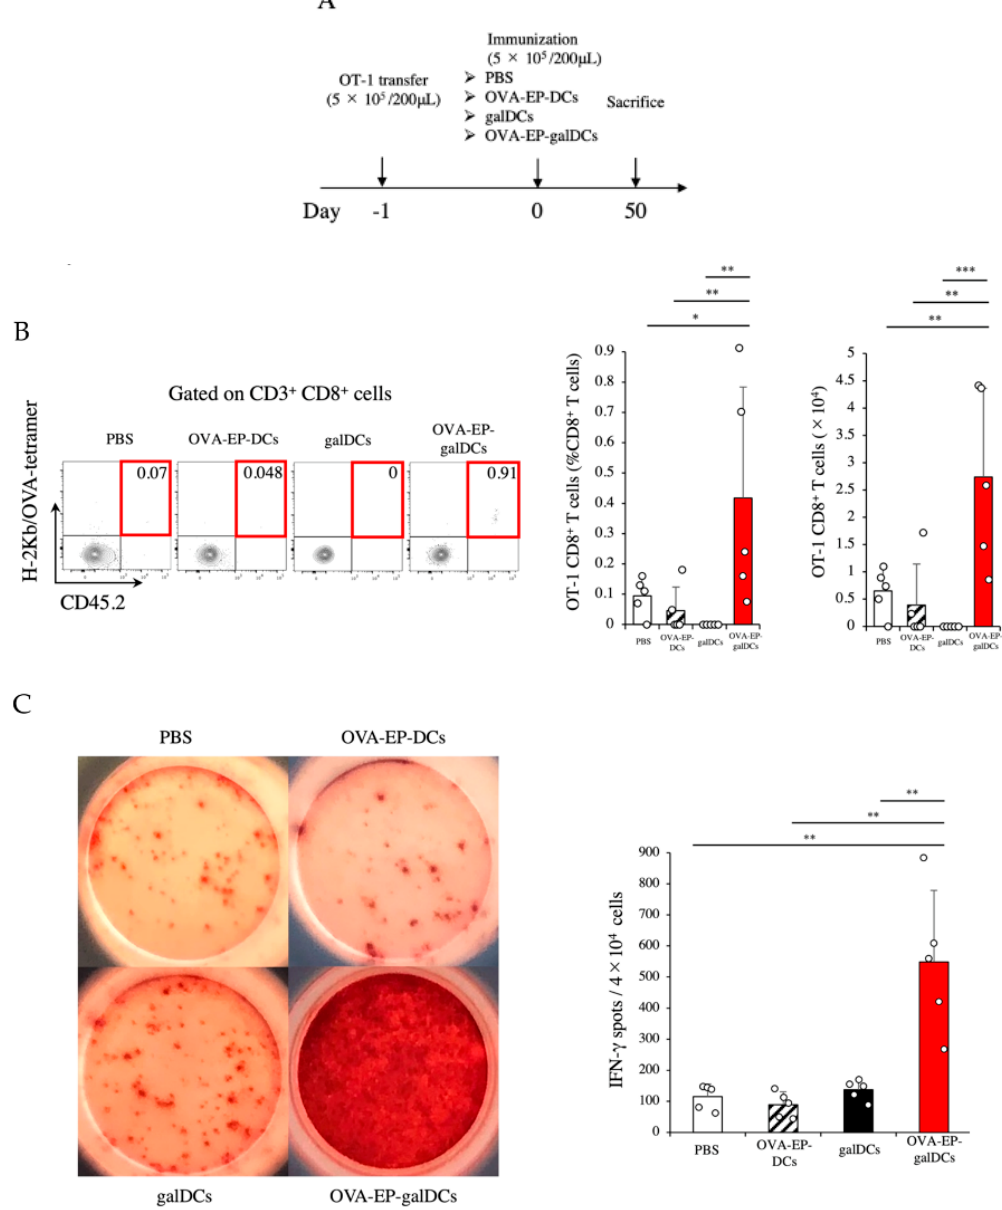
Figure 5. OVA-EP-galDCs induced OT-1 CD8 + memory T cells in the spleen. ( A ) On day 50, the frequency and the number of OT-1 CD8 + T cells (H-2Kb/OVA-tetrameter + CD45.2 + CD8 + T cells) in the spleen were assessed by flow cytometry. ( B ) Typical examples of flow cytometric analysis, the frequency, and the number of OT-1 CD8 + T cells in the spleen are shown ( n = 5). ( C ) IFN- γ secretion of splenic CD8 + T cells was assessed by ELISPOT assay on day 50. Splenic CD8 + T cells were sorted by MACS and cocultured with DCs stimulated with OVA peptide (SIINFEKL) and the IFN- γ spots were shown. The number of spot-forming cells was counted manually ( n = 5). To analyze statistical differences among multiple groups, ANOVA with Holm’s post hoc test was performed. * p < 0.05, ** p < 0.01, and *** p <